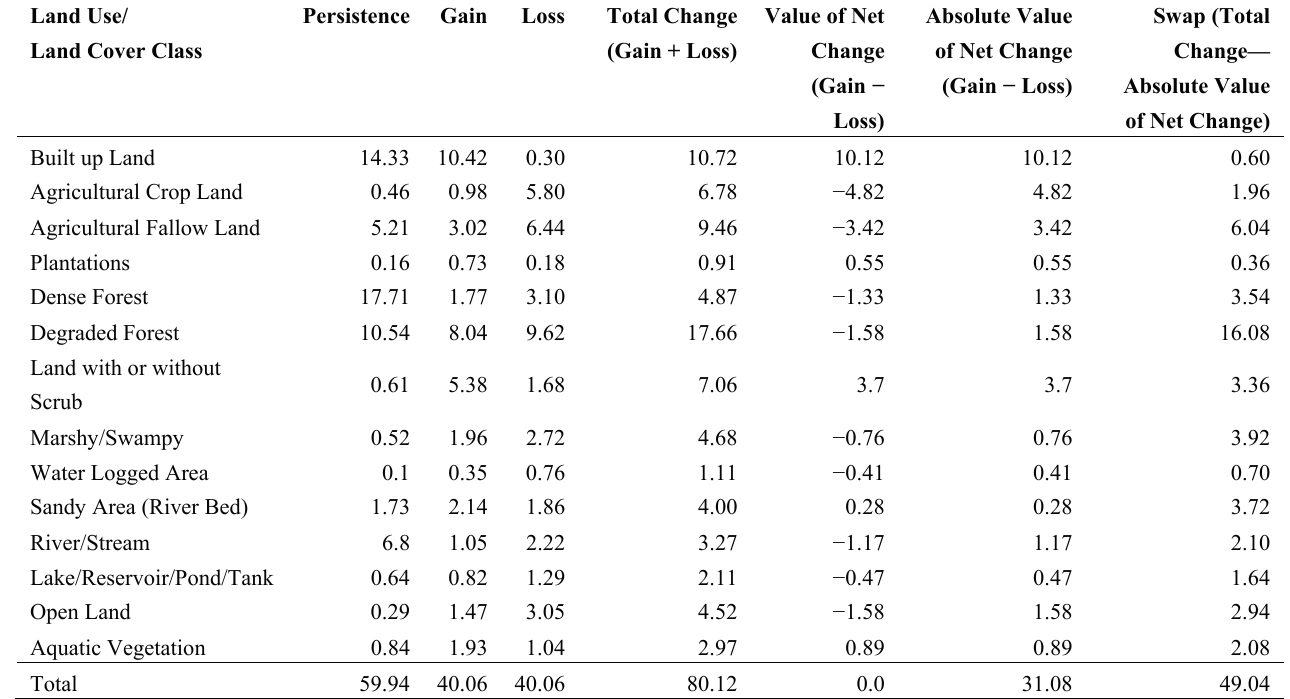
Table 9. Statistics of landscape persistence and components (gains and losses) of change in terms of percent of study area in the time periods 1987–1997.